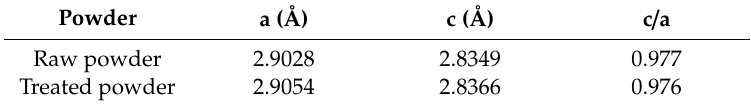
Table 3. Calculated lattice constants of the raw powder and the plasma-treated